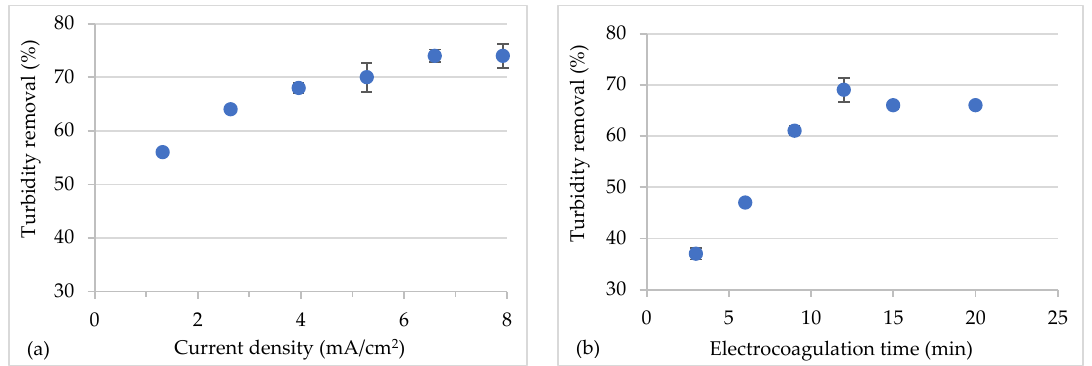
Figure 4. E ff ect of applied current density ( a ) and electrocoagulation time ( b ) during electrocoagulation Figure 4. Effect of applied current density ( a ) and electrocoagulation time ( b ) during on turbidity removal. The error bars represent the variability of duplicate electrocoagulation on turbidity removal. The error bars represent the variability of duplicate experiments.